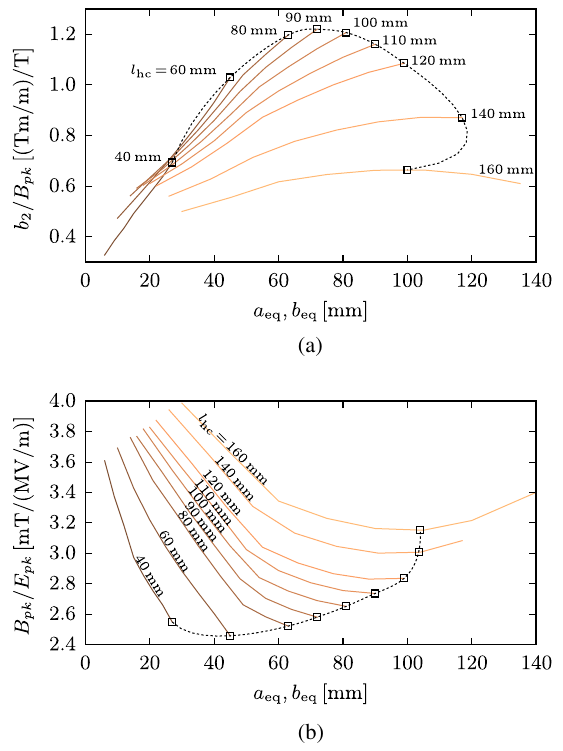
FIG. 4. Quadrupolar strength b 2 with respect to the surface peak field B pk (a) and the ratio B pk =E pk (b) of an 800 MHz non-reentrant elliptical cavity. The iris ellipse is fixed to a b ¼ 10 mm while the equator ellipse varies under the condition ir a ¼ b resulting in a circular profile. Besides, different cavity eq eq lengths l are compared to each other showing the maximum in hc (a) close to λ = 2 .